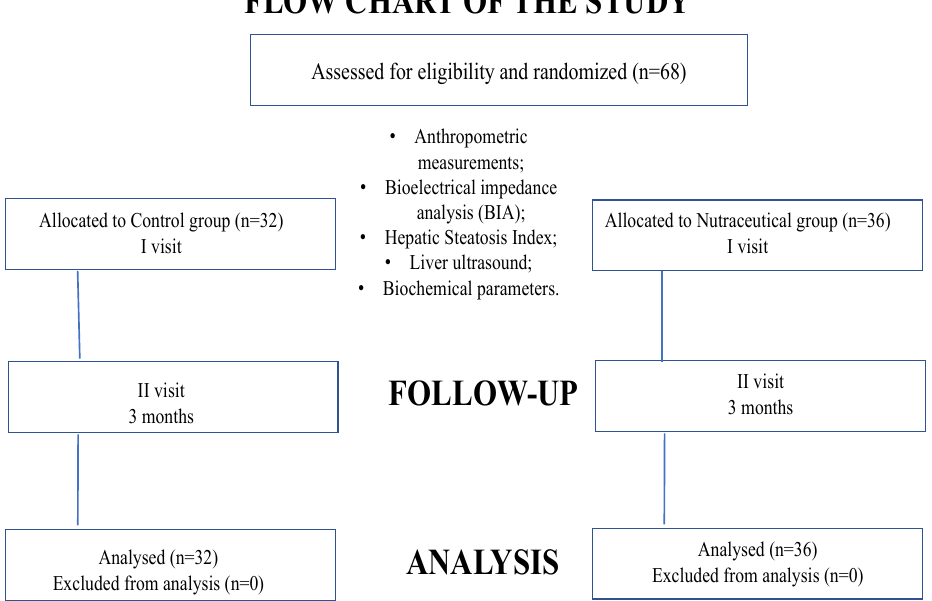
Figure 1. Flow ‐ chart illustrating study population. Figure 1. Flow-chart illustrating study